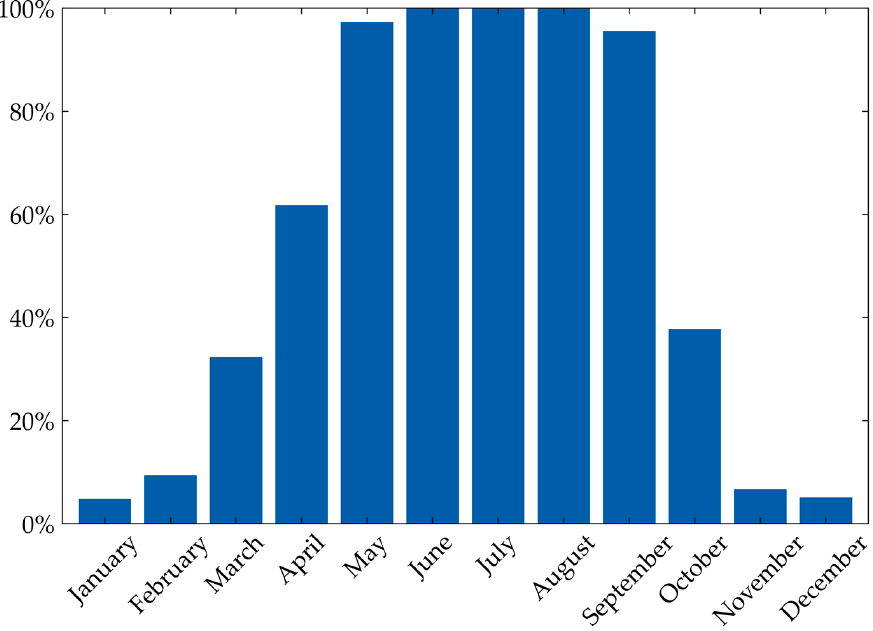
Figure 9. SAH contribution percentage throughout the year after the renovation of the Welsh site room.